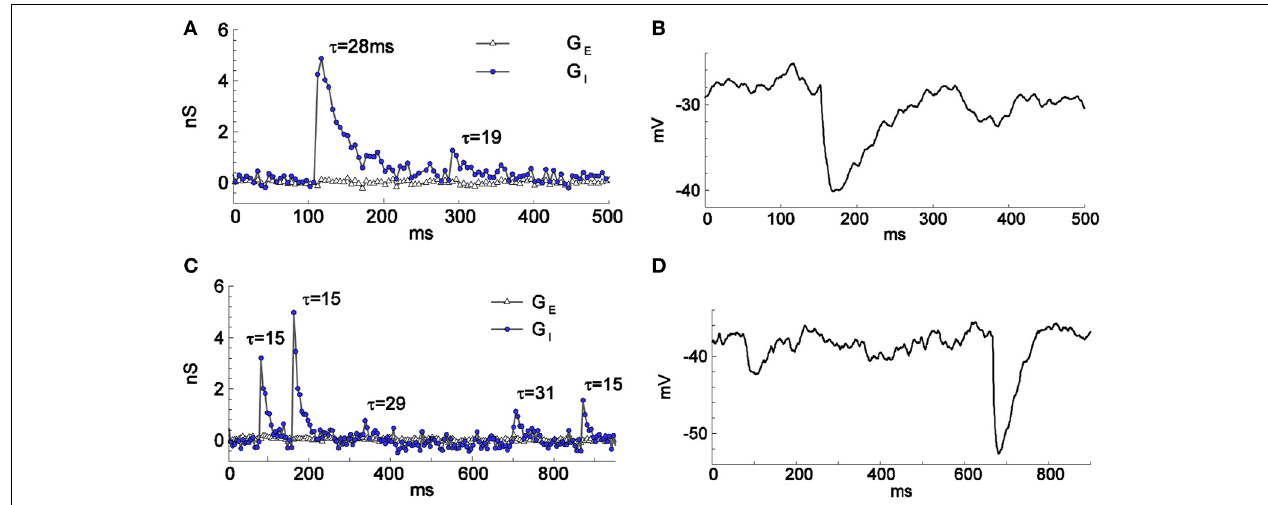
FIGURE 4 | Spontaneous GABA-mediated postsynaptic events of different amplitudes and time courses recorded in firing-clamp (A,C) and current-clamp (B,D) regimes. Recordings from two cells (one in A,B and another in C,D ) different from the cell of